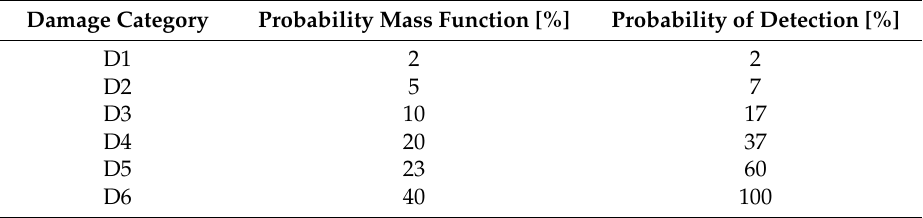
Table 6. Recommended probabilities of detection (PoDs) for visual